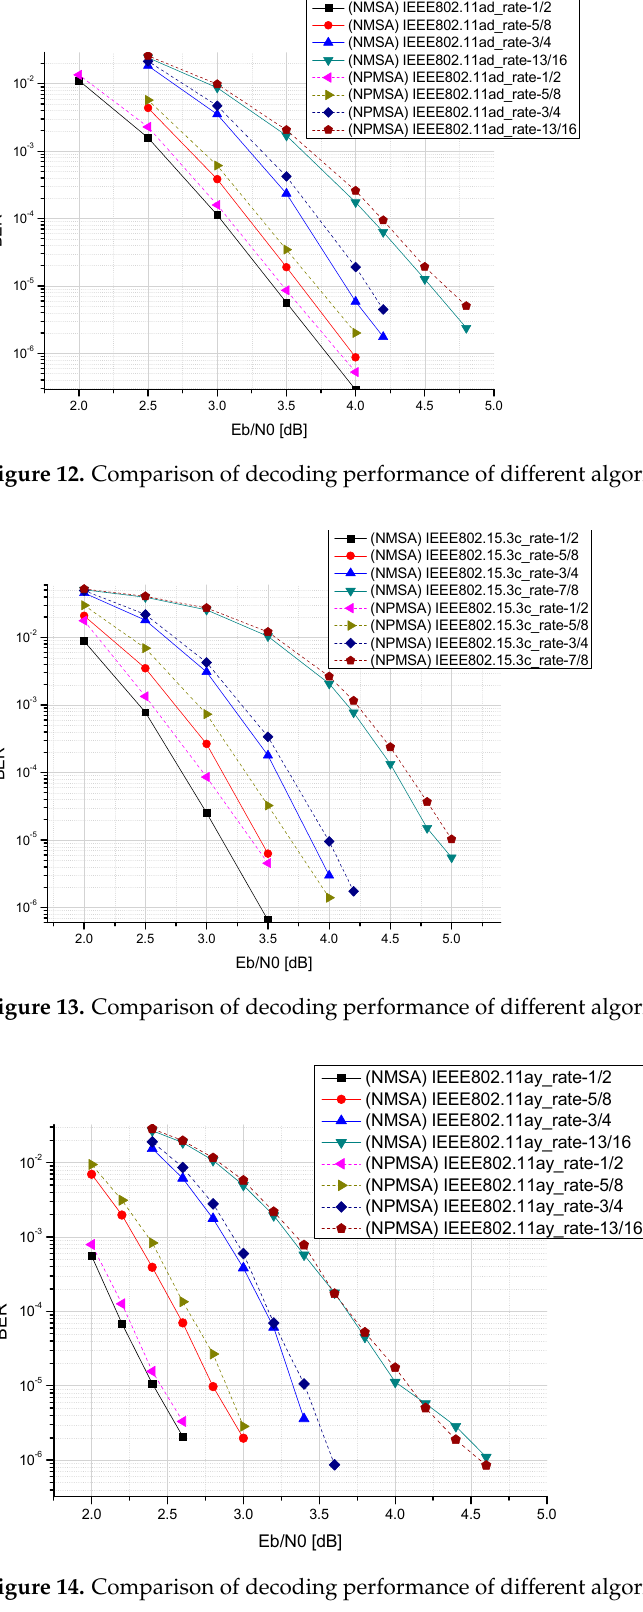
Figure 14. Comparison of decoding performance of different algorithms in IEEE 802.11ay. After confirming the performance of the algorithm through a floating-point simula- tion, the fixed-point simulations are used to determine the finite word-lengths required for the quantised multimode LDPC decoding on the hardware. The integer digits are fixed and the fractional bits are increased upwards, as shown in Figures 15–17. The bit is repre- sented as (integer bit, fractional bit), and the integer bit does not include a sign bit. Finally, we set the integer bits to five, with one fractional bit. The total number of bits, including the sign bit, is seven. The simulated performance was close to the result of the floating- point simulation. Figure 15. Fixed-point simulation in IEEE 802.11ad R = 13/16.